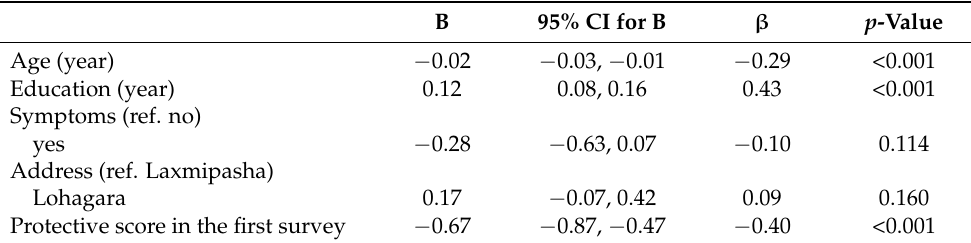
Table 3. Liner regression model (adjusted standardized coefficient) for changes in pesticide protective behavioral